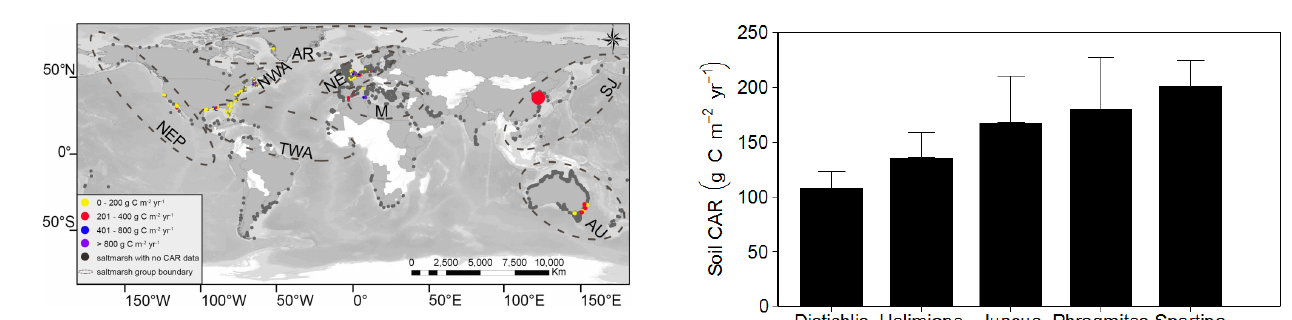
Figure 1. Groupings and CAR of global salt marsh ecosystems. The eight groups span latitudes from 40 ◦ S to 69.7 ◦ N, colonizing the coasts and estuaries of the Pacific, Atlantic, Indian and Arctic oceans. The background graph indicating sites of salt marshes is based on Mold (1974) and Murray et al. (2011). While significant salt marsh occurrences are present in South America, insufficient data is available for inclusion in this analysis since there are no per- tinent references. Color dots are used to account for CAR levels of individual sites that were indicated in Table 1 from 50 studies, whereas dull color dots represent sites without CAR data. There are not substantial data for the Sino-Japan region, as such a big circle is used to represent the average CAR of this region. Only locations with published data allowing calculation of CAR are represented for clarity. NEP – NE Pacific; TWA – tropical W Atlantic; NWA –